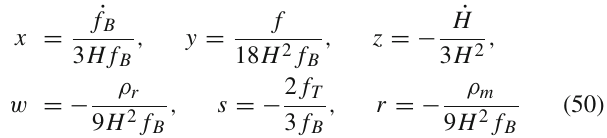
Table 3 Critical points for this system of equations Critical points Exists